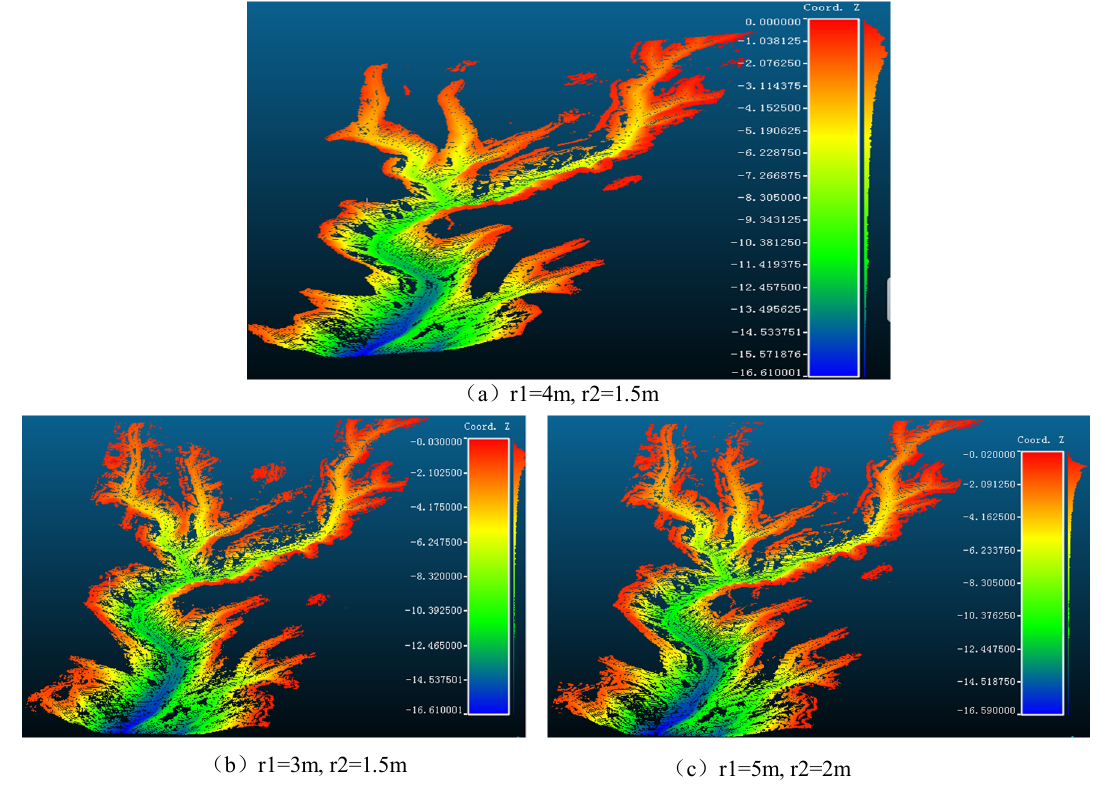
Figure 5. The segmentation results of different